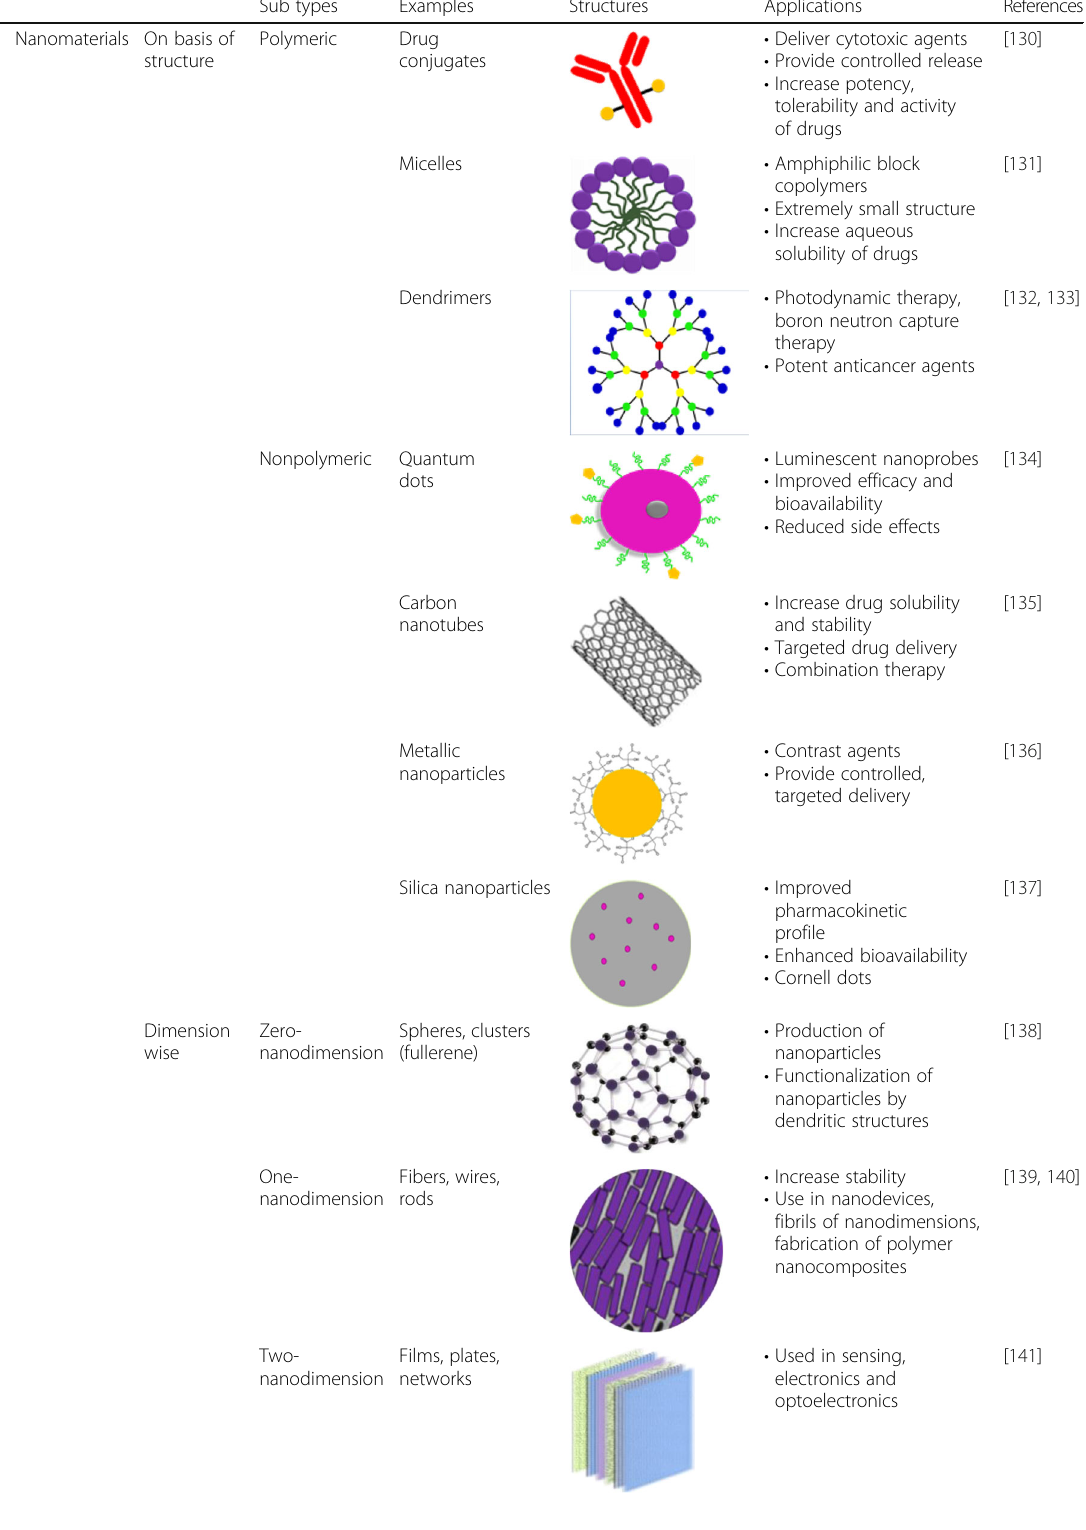
Table 1 Pharmaceutical nanosystems (classification of